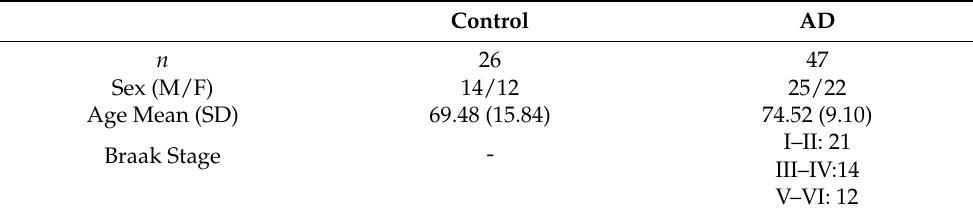
Table 2. Demographic and clinical data of brain tissue